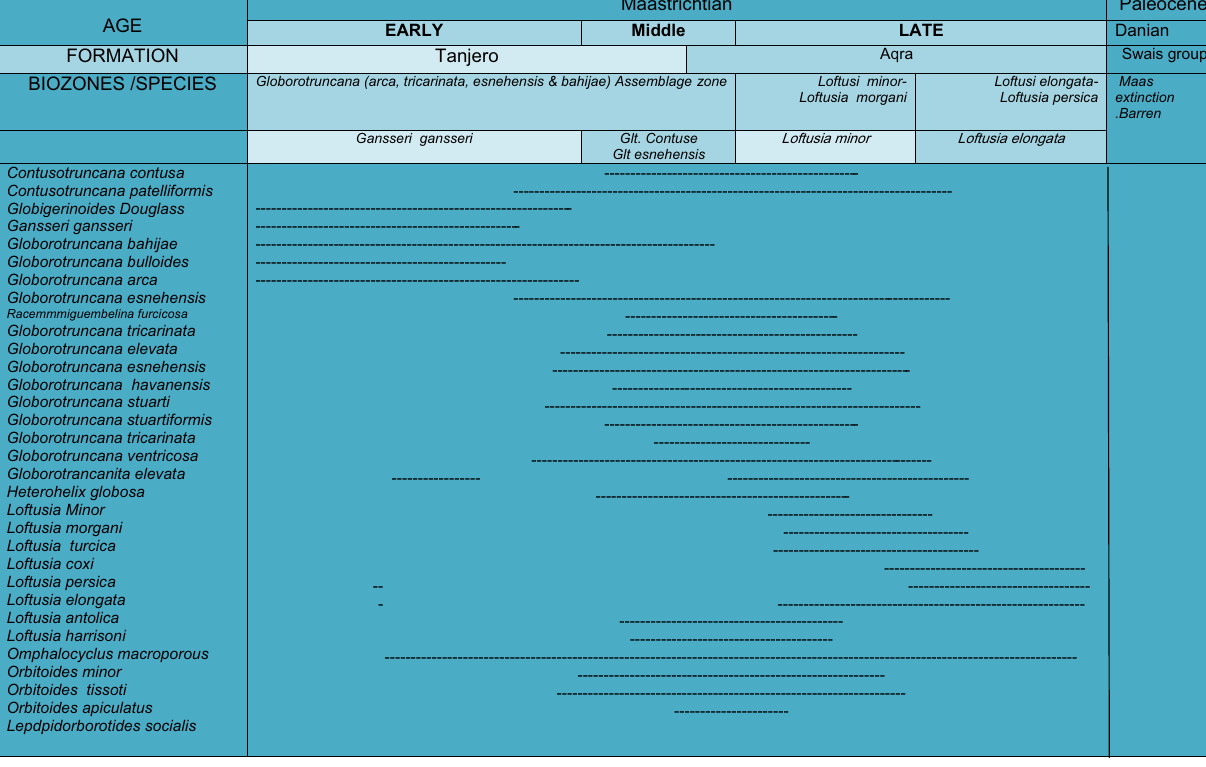
PaleoceneMaastrichtian